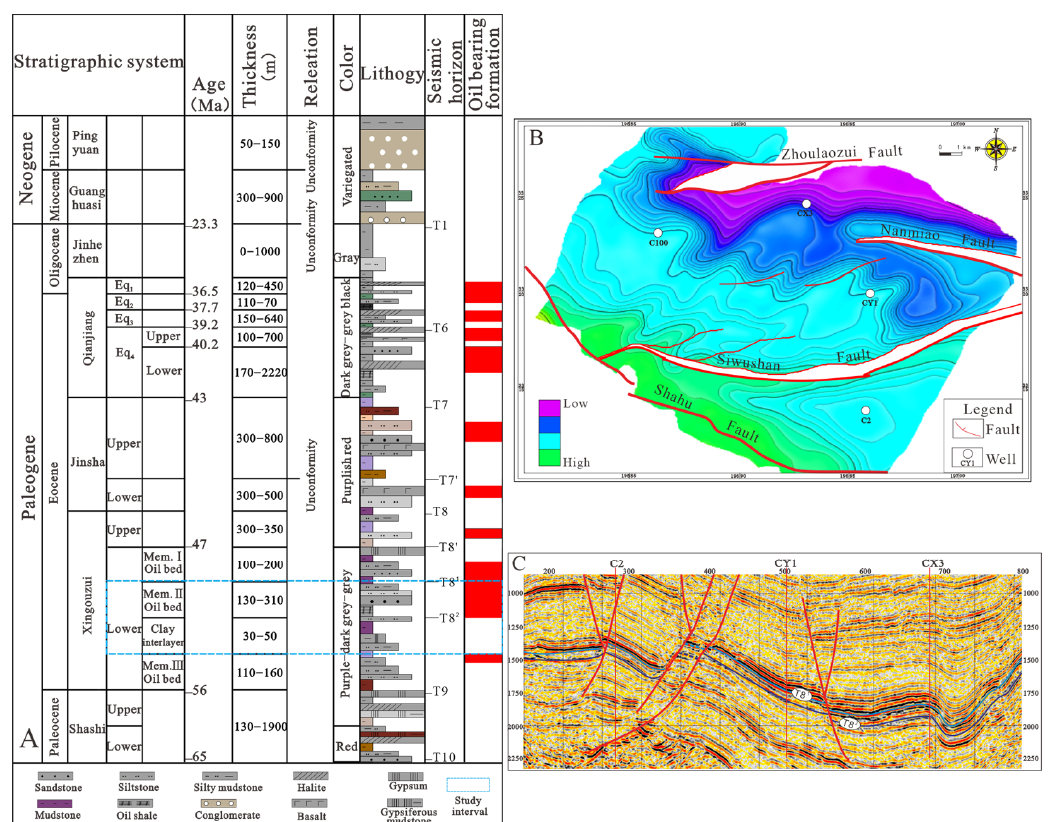
Figure 1. Generalized structural units map of the Jianghan Basin and research area modified from [24,27].